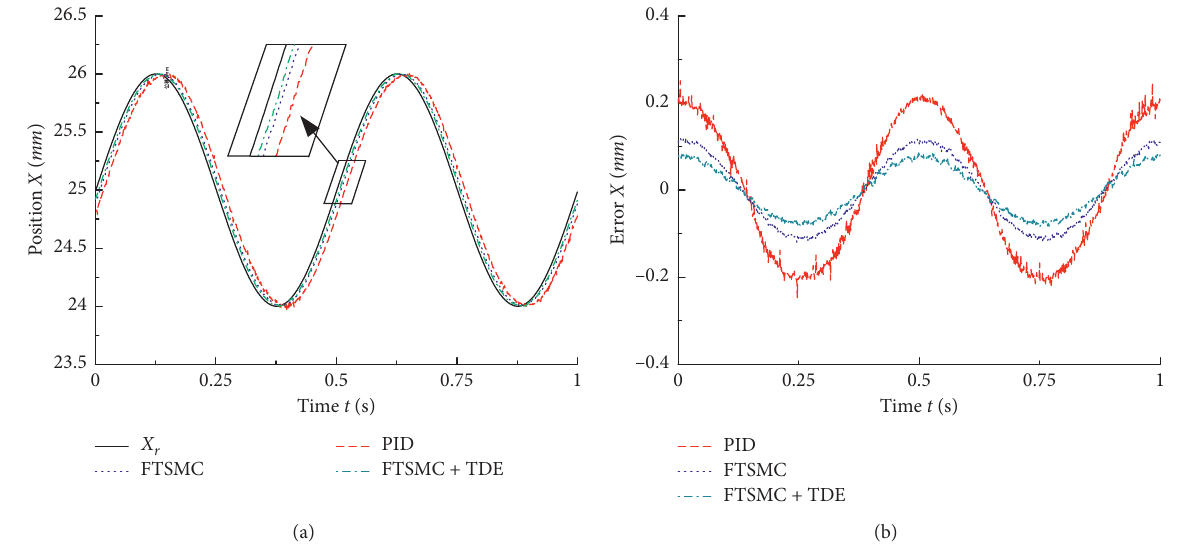
Figure 9: Working condition ② in Table 4. (a) Position of 1 mm amplitude and 2 Hz frequency. (b) Position error of 1mm amplitude and 2Hz frequency.